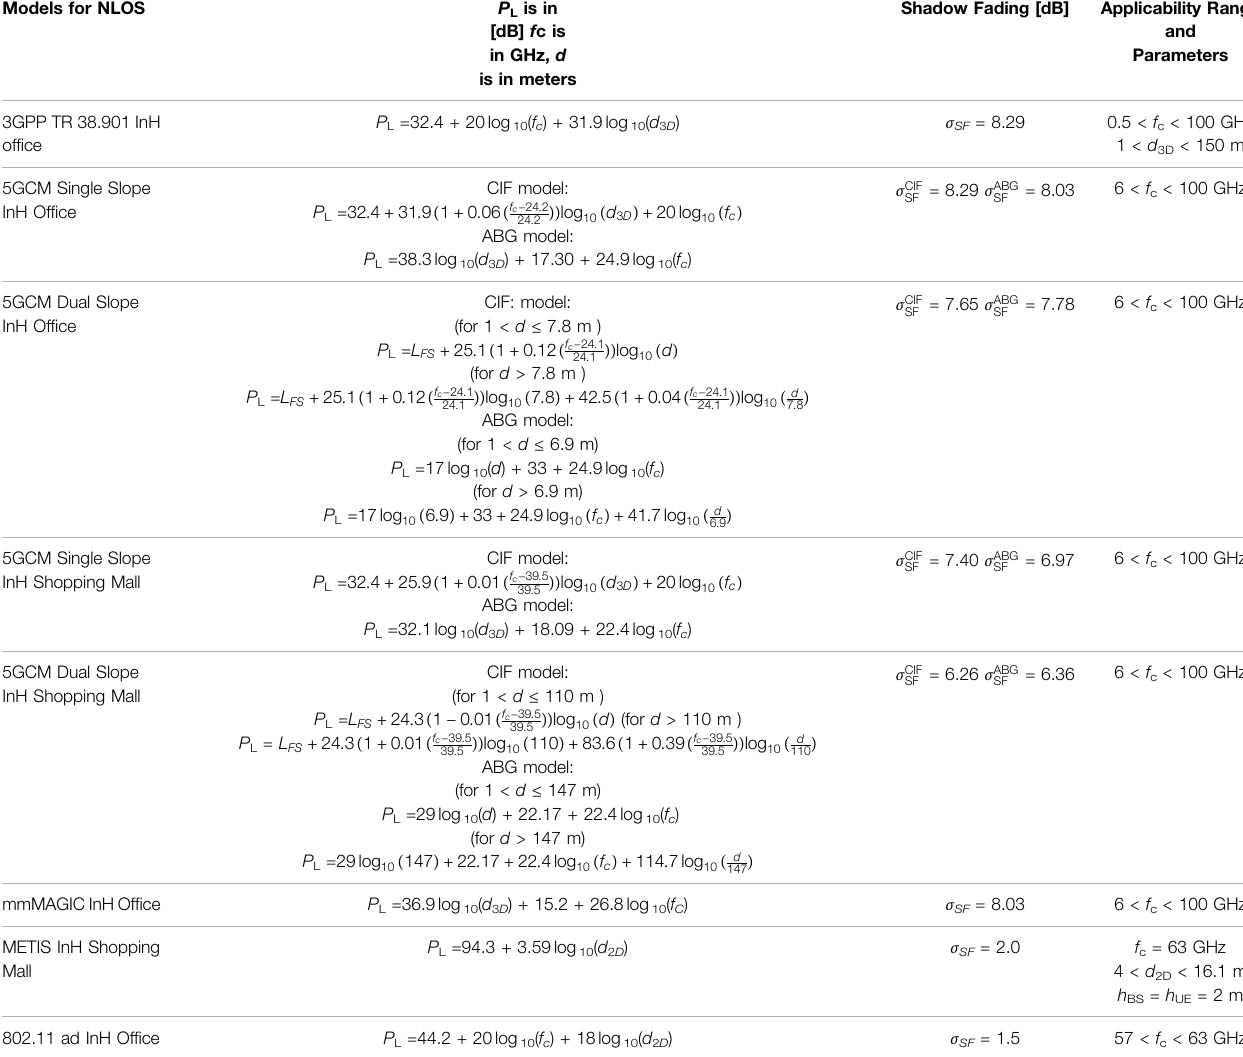
TABLE 3 | Channel models for NLOS indoor of fi ce and shopping mall scenarios (Rappaport et al., 2017). Models for NLOS P L is in